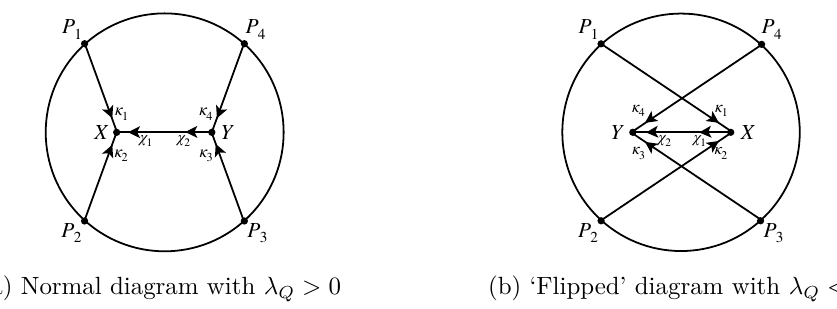
Figure 12. Normal and ‘flipped’ scalar exchange